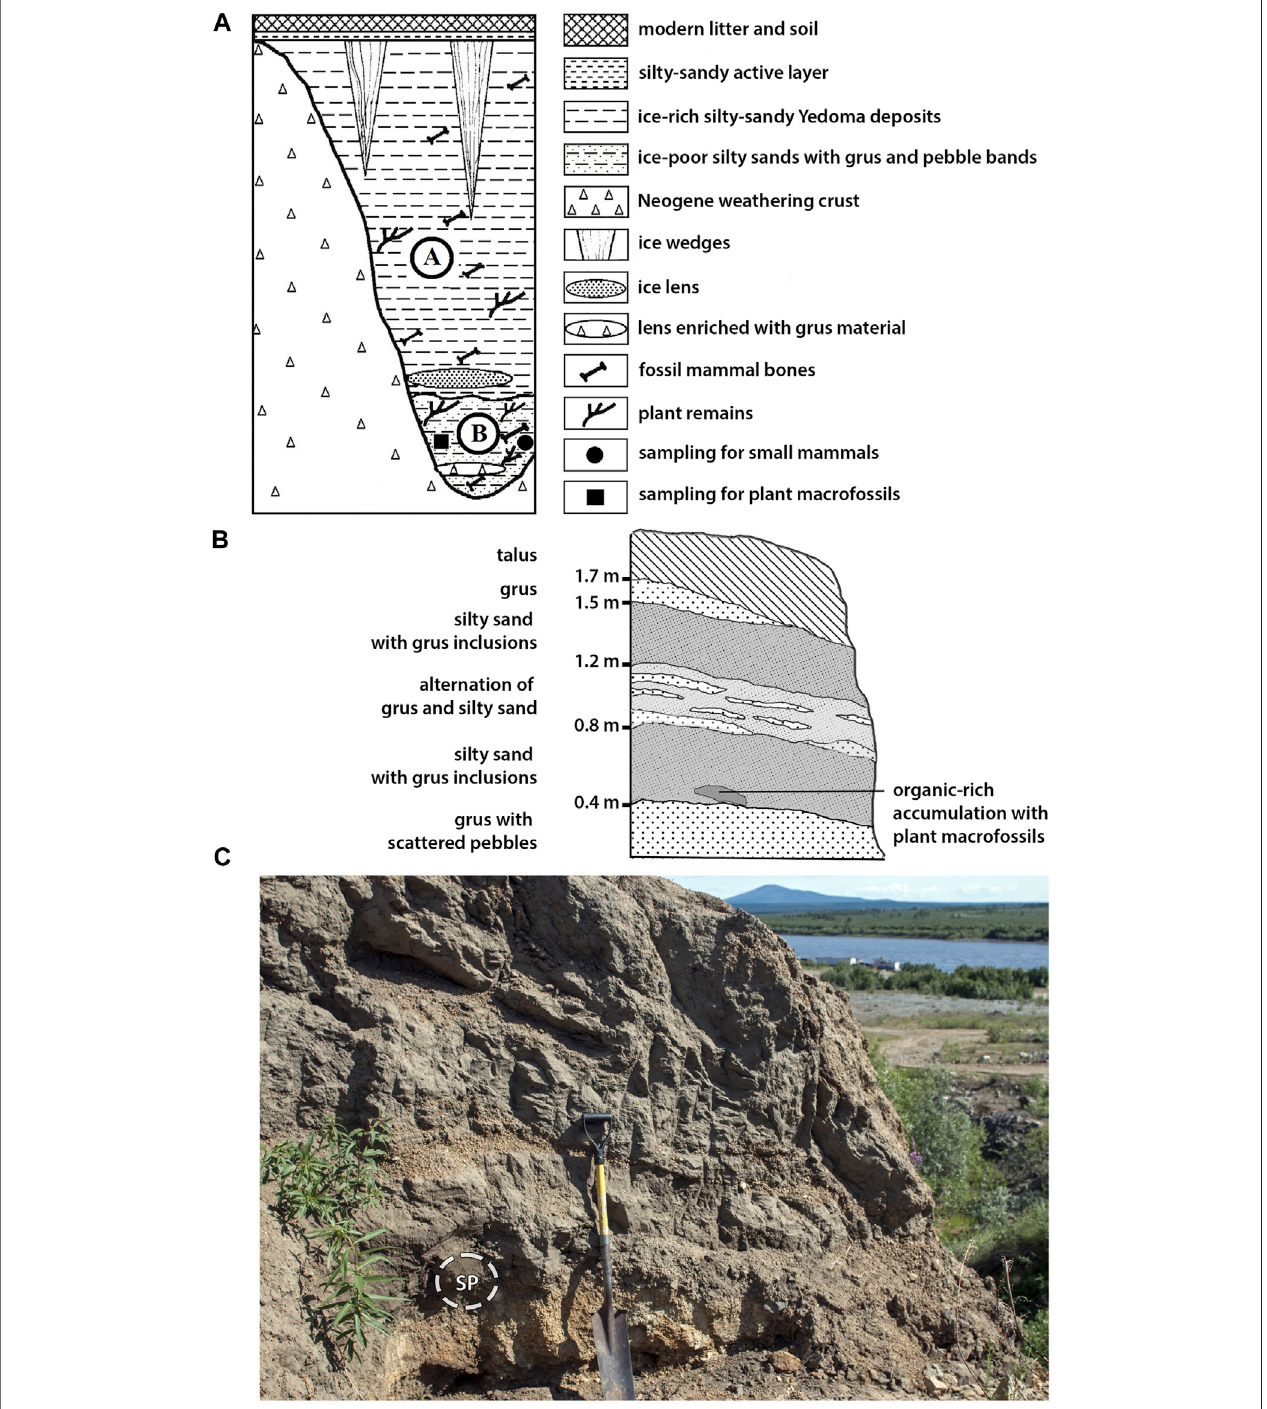
FIGURE 2 | (A) Scheme of the original stratigraphic sequence at the Cherskiy Ovrag reconstructed on the basis of long-term monitoring by S.P. Davydov. The upper unit A – the late Pleistocene Yedoma Ice Complex — became eroded in the frame of industrial exposure and subsequent thawing, which gave access to the underlying unit B – the Olyorian sequence. (B) Sketch and description of the Olyorian section (unit B) exposed at the time of sampling. (C) Photo of the studied exposure and sampling point (SP) within the sequence. In the background, the Panteleikha River and Mt. Panteleikha are visible.